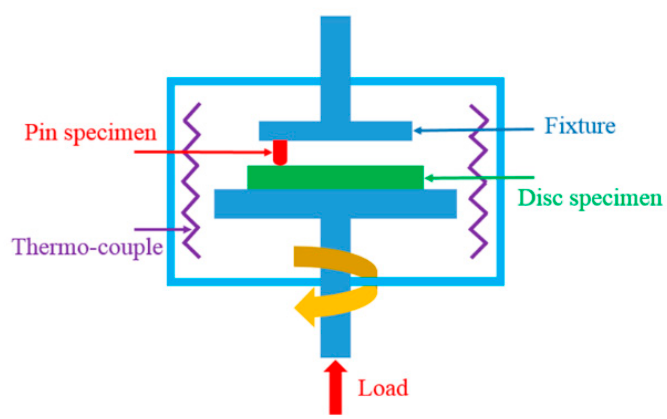
Figure 1. The schematic diagram of the multifunctional friction and wear testing machine.